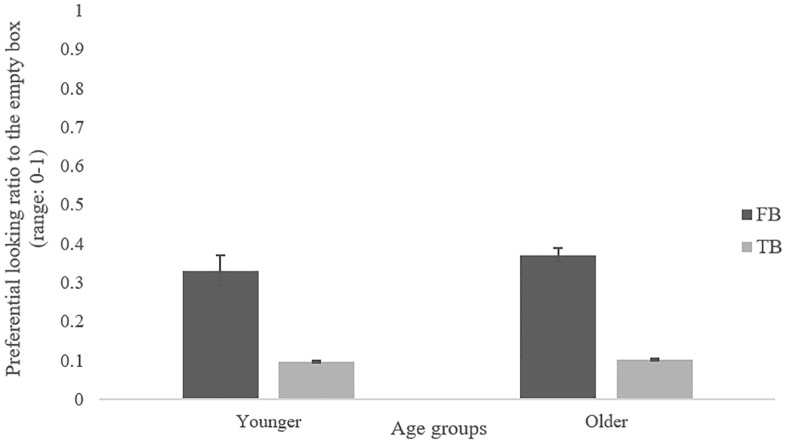
Preferential looking ratios, with a score of 0 meaning looking only to the animal box, a score of 1 meaning looking only to the empty box.Error bars represent standard errors.